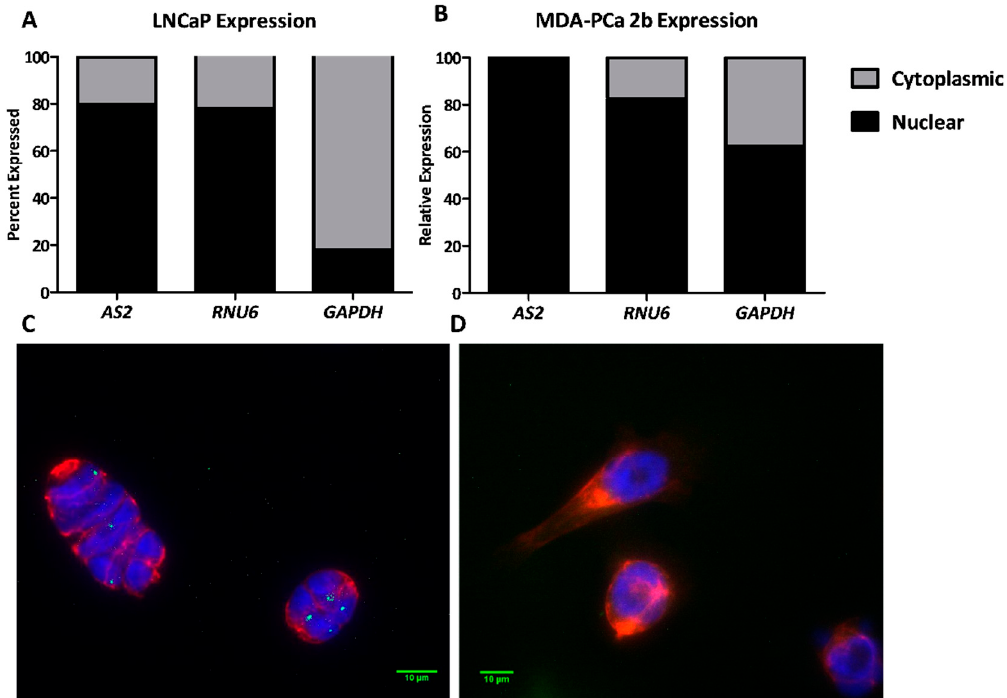
Figure 7. AS2, RNU6 , and GAPDH transcripts levels were analyzed via qPCR in the cytoplasmic and nuclear fractions of LNCaP and MDA-PCa 2b cells ( A , B ). AS2 RNA transcripts (green), cytokeratin protein (red), and nuclear DNA (blue) were visualized using RNA in situ hybridization and immunofluorescence in LAPC-4 ( C ) and PC3 ( D ), respectively.